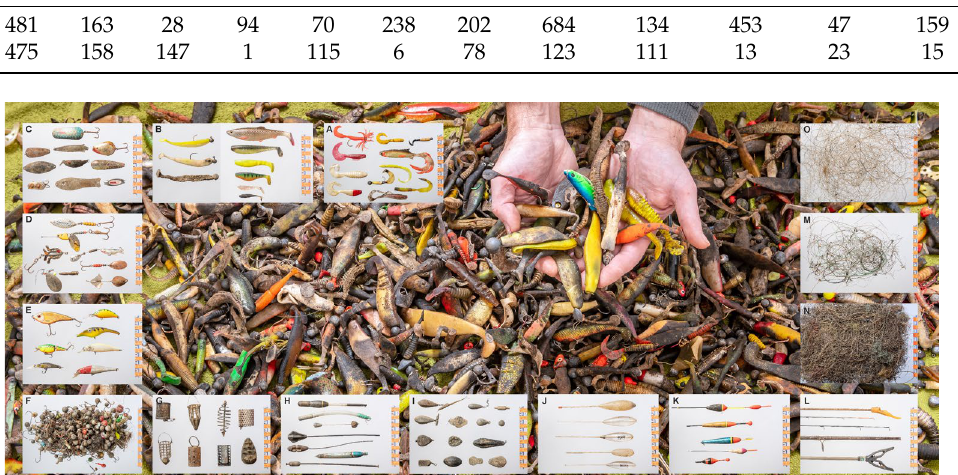
Figure 2. Diversity of angling gear collected in Lake Eixendorf. A = soft bait, twister, and shads with twister tail; B = soft bait, shads with and without jighead; C = metal spoons; D = spinner and spinner bait; E = hard plastic lures; F = lost jigheads; G = feeder baskets; stand-up sinkers; H = lead sinkers; J = underwater floats; K = floats; L = rod holders and broken fishing rods; N = braided fishing line; M = steel leader; O = monofilament fishing line. Table 1. Classification of lost fishing tackle found in Lake Eixendorf attributed to active and passive fishing methods or not being attributed (N.A.). Items are displayed in Figure 2. Overall = weight (g) of items (n) for the respective item class, condition of items is attributed to N = new, G = good, M = medium, P = poor, or R = rotten.